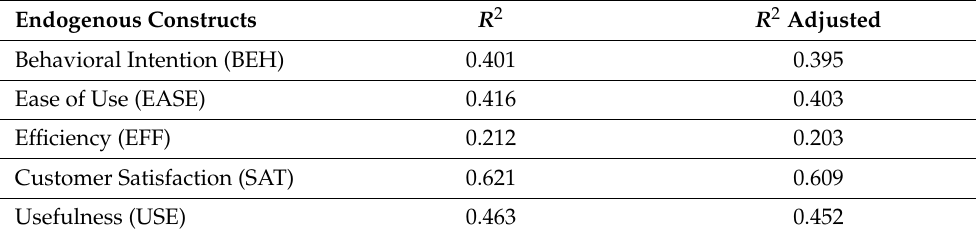
Table 6. Results of testing the explanatory power of the research